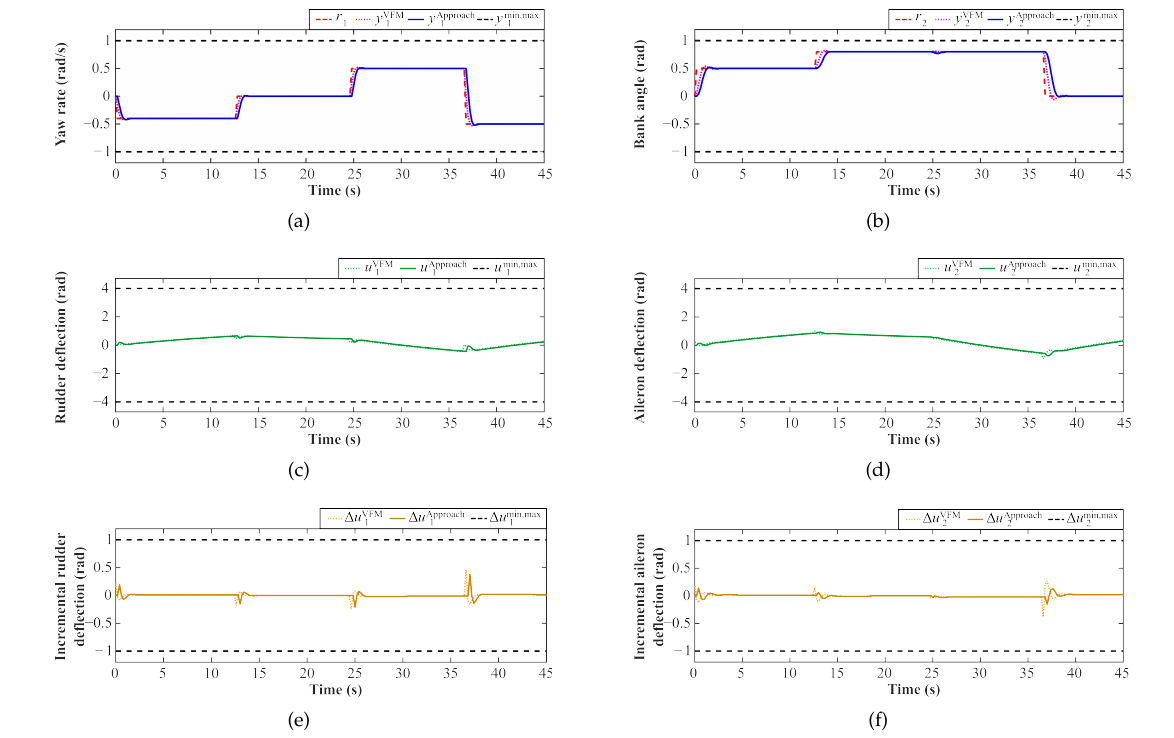
Figure 8. Results for the jet transport aircraft under VFM and Approach: ( a ) Yaw rate. ( b ) Bank angle. ( c ) Rudder deflection. ( d ) Aileron deflection. ( e ) Incremental rudder deflection. ( f ) Incremental aileron deflection.